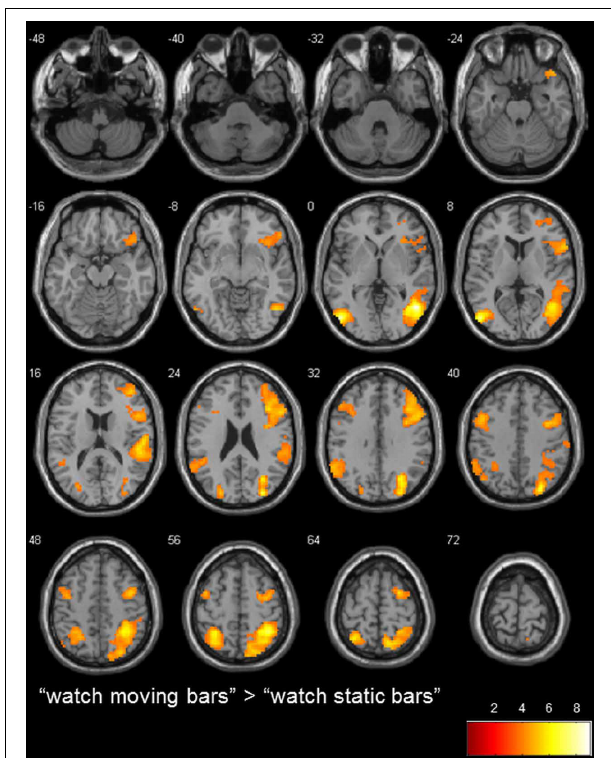
FIGURE 3 | transversal slices (8mm spacing); t-score map for “watch moving bars” > “watch static bars”; p < 0 . 001 uncorrected on voxel-level, p < 0 . 05 corrected for multiple comparisons on cluster-level (false discovery rate [FDR]); minimum cluster size 10